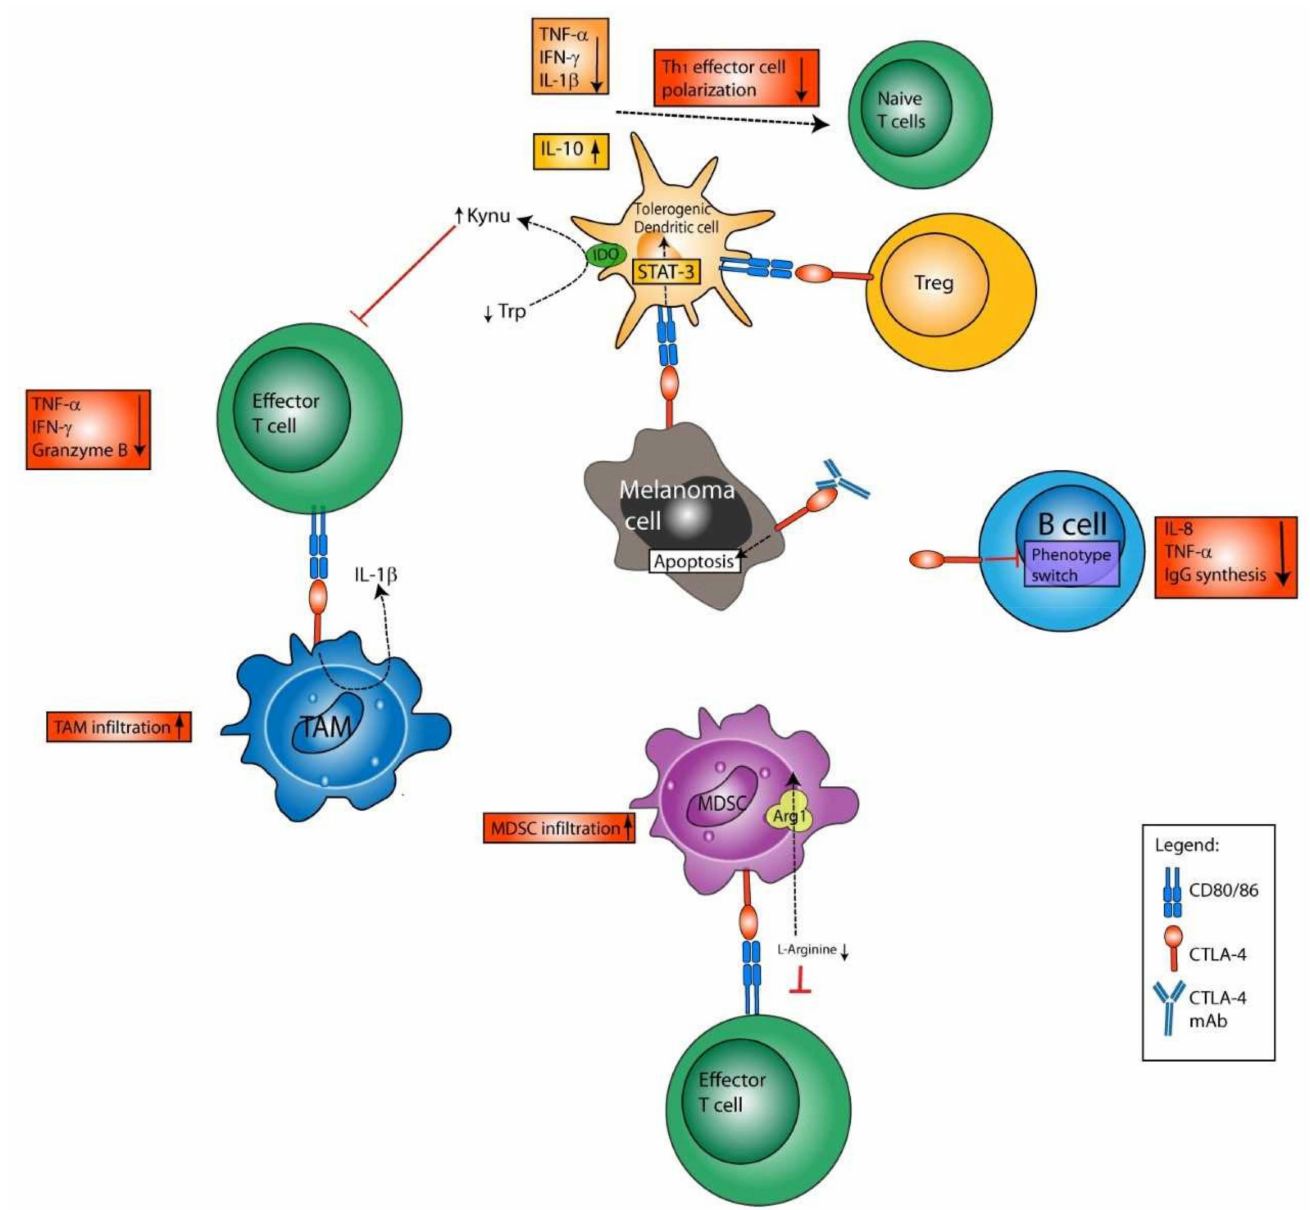
Figure 2. Immunomodulatory role of cytotoxic-T-lymphocyte antigen 4 (CTLA-4). CTLA-4 is ex- pressed by regulatory T cells (Tregs), tumor-associated macrophages (TAM), myeloid-derived sup- pressor cells (MDSCs), dendritic cells (DCs), B cells and melanoma cells. The interaction of CTLA-4 on melanoma cells, as well as Tregs, with DC-bound CD80/CD86 resulted in the polarization of DCs towards a tolerogenic phenotype. Such DCs conferred depletion of tryptophan (Trp) from the microenvironment via IDO activation, and at the same time enhanced levels of Trp degradation products, termed kynurenins (Kynu). Both Trp depletion and Kynu impair activation/polarization of naïve T cells towards Th1 T effector cells and effector T cell functions. Further, tolerogenic DCs generate soluble anti-inflammatory agents, such as IL-10, which also contribute to T-cell impairment. Further, binding of CTLA-4 on TAMs and MDSCs with CD80/CD86 on T effector cells has been found to impair anti-tumor activity and enhance the infiltration of TAMs and MDSCs into the tumor microenvironment. Lastly, the binding of CTLA-4 on B cells, presumably via CD80/86 on activated T cells (not shown), has been found to reduce antibody synthesis and Ig class